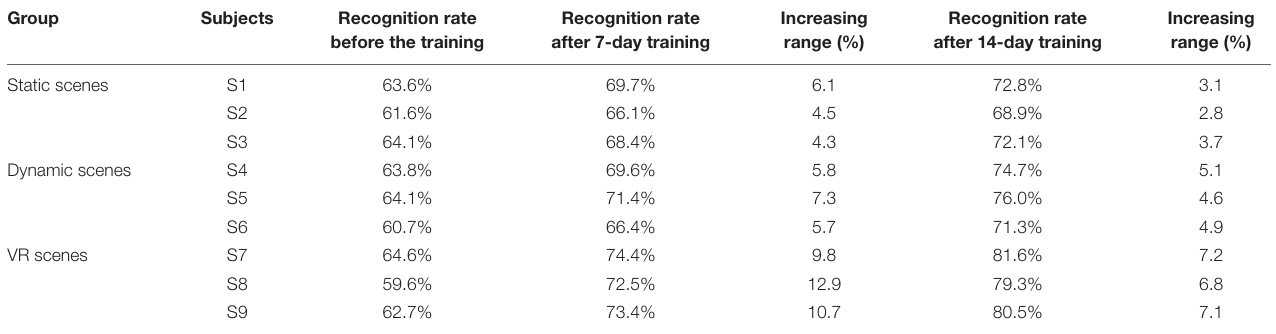
Group Subjects Recognition rate